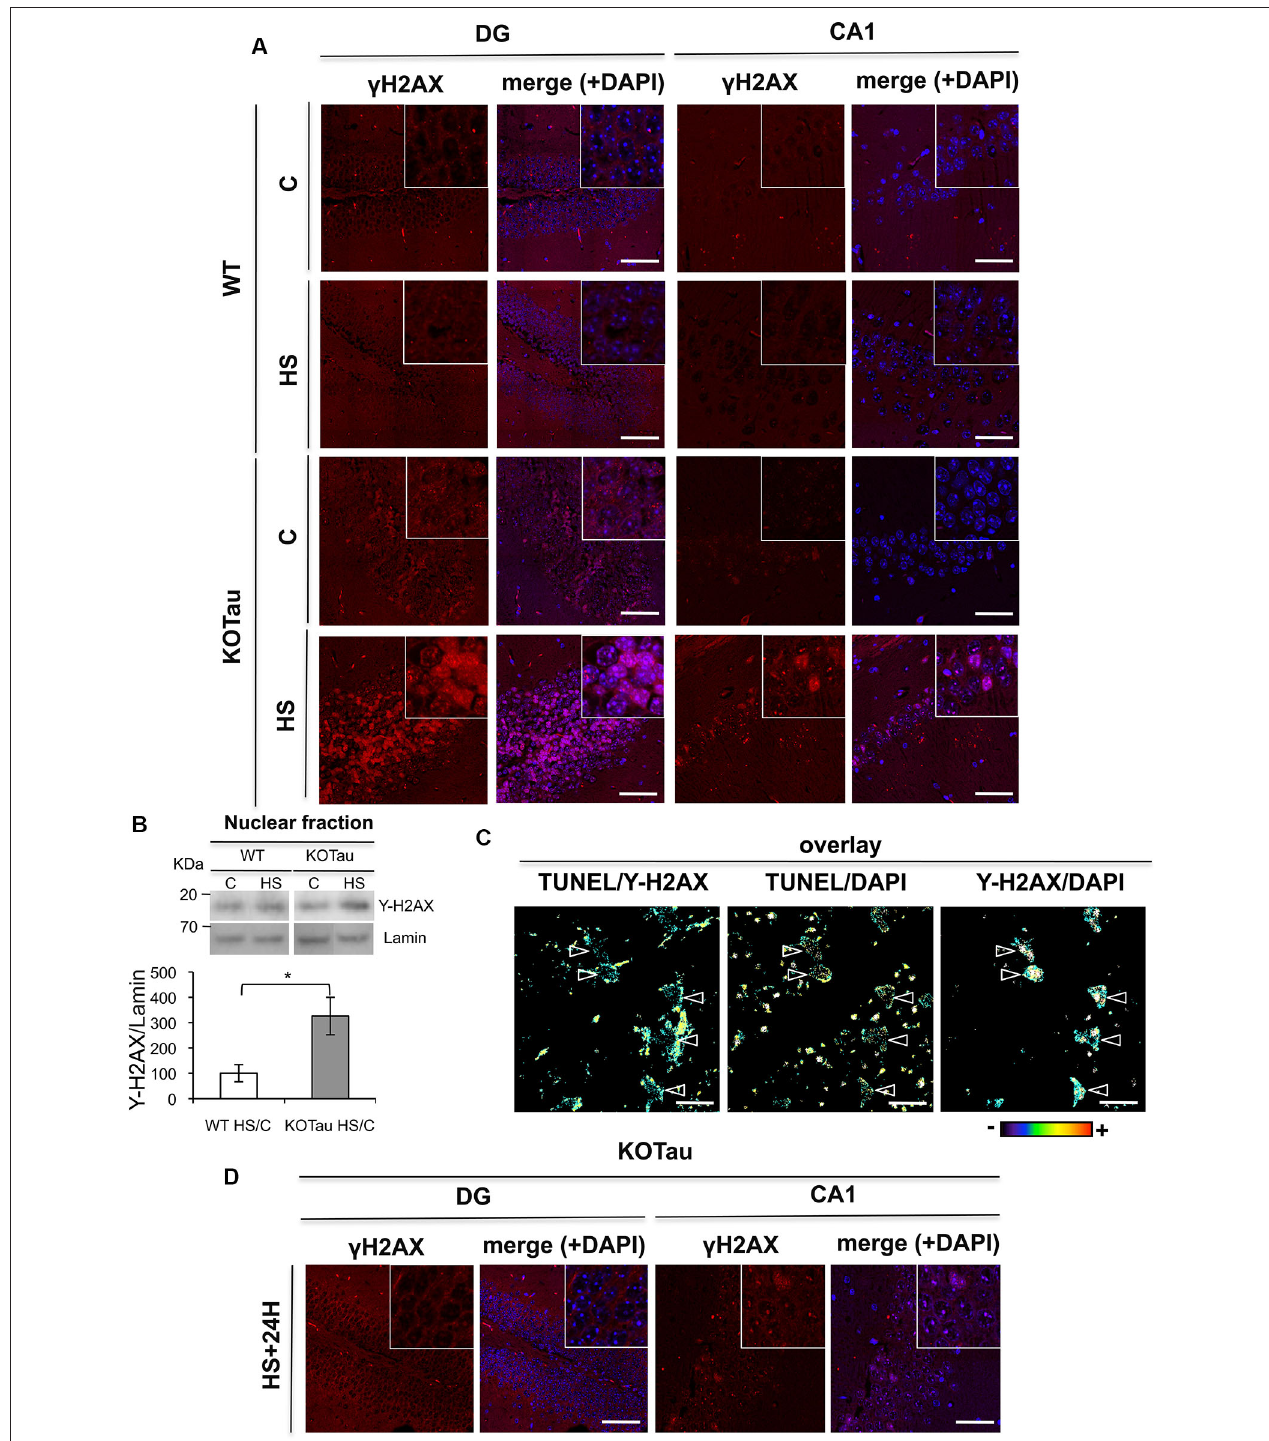
HS induced a strong increase in γ -H2AX specifically in the KO-Tau hippocampus. The scale bars indicate 50 µ m. (B) Nuclear extracts of the hippocampus from WT and KO-Tau mice in the C or HS condition were analyzed using immunoblotting for γ -H2AX. Lamin B was used as a specific nuclear loading protein. (C) Sagittal DG sections from WT and KO-Tau mice ( Continued